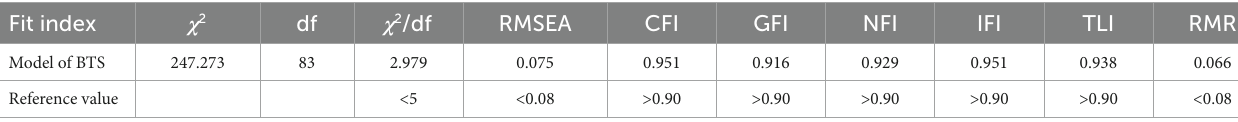
TABLE 4 Results of confirmatory factor analysis ( n =